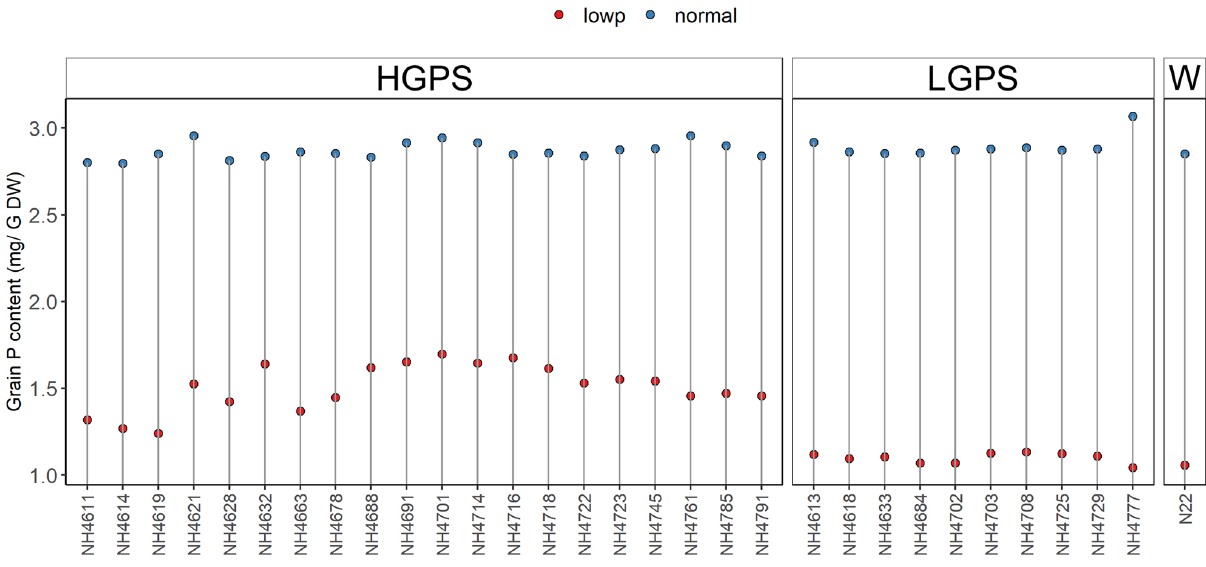
Figure 1. Initial grain P concentration in seeds collected from low P (shown in red dots) and normal P (shown in blue dots) filed